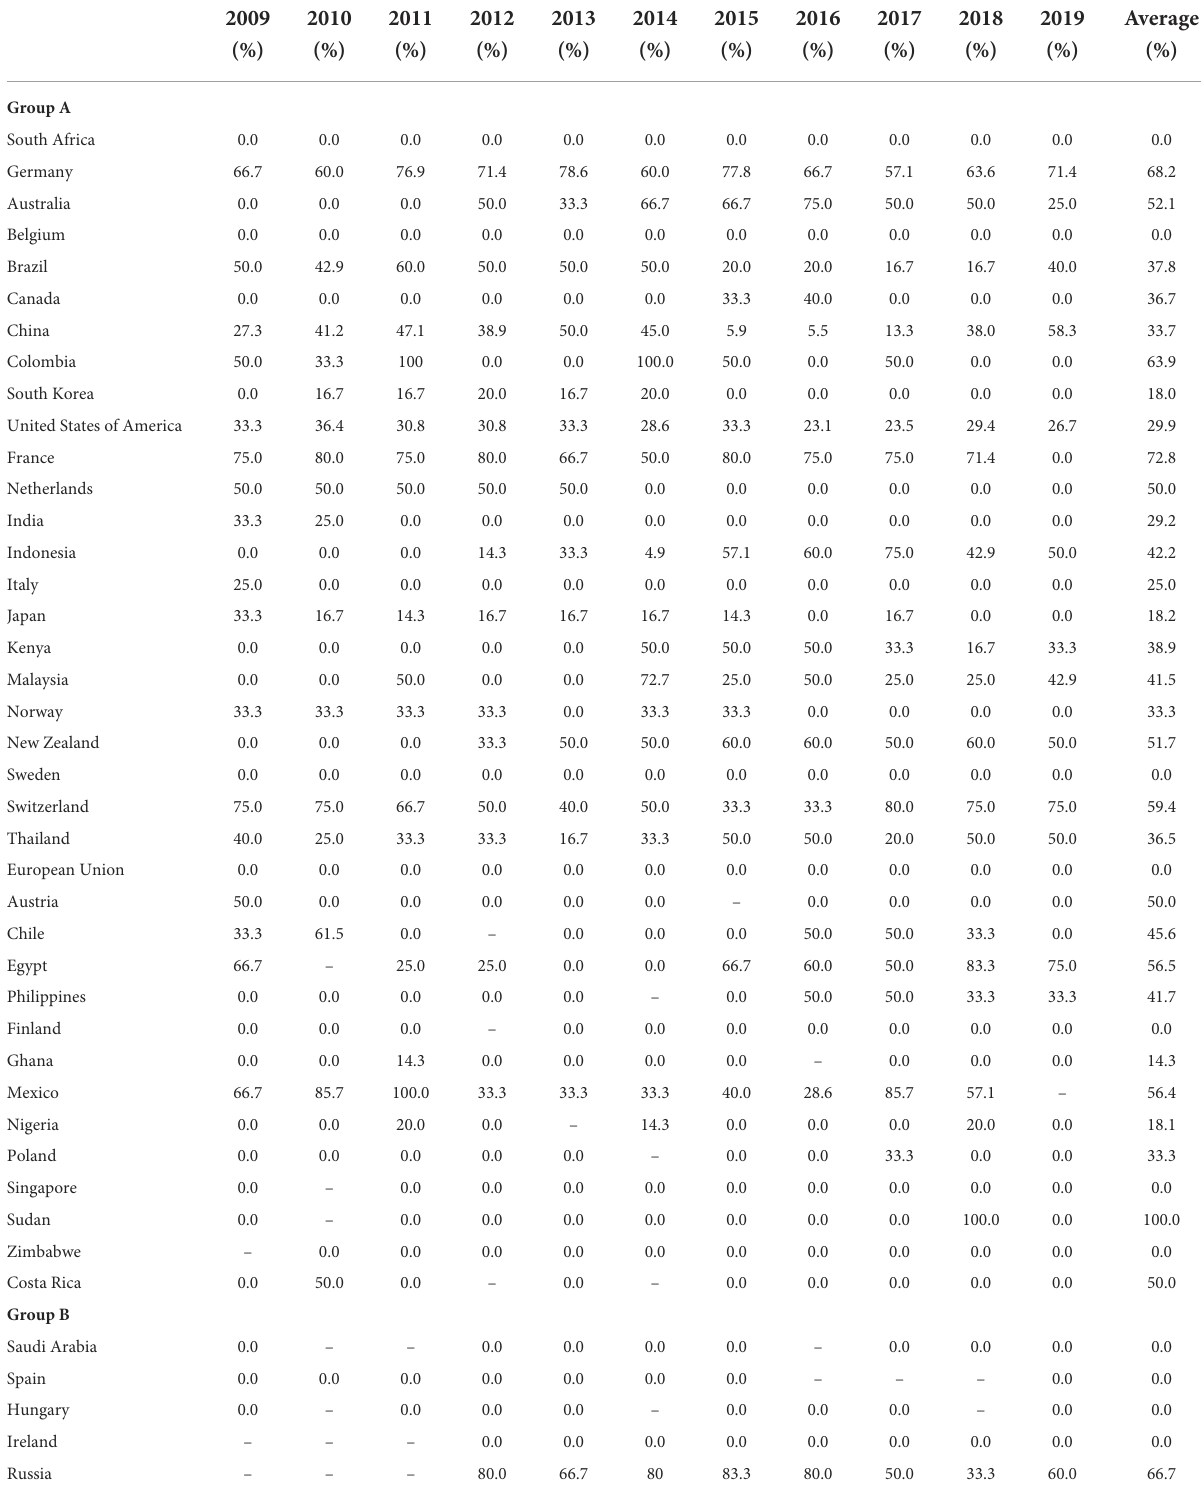
TABLE 4 Private interest participants rate in member countries delegations attending CCNFSDU a ,